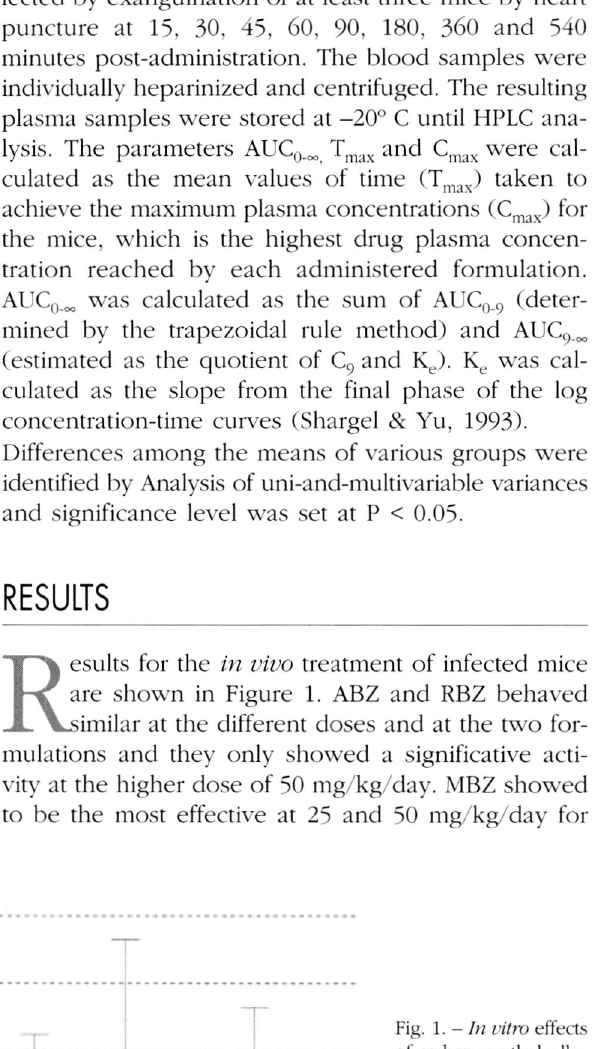
Fig. 1. -In vitro effects of carboxymethylcellu- lose (CMC)- and poly­ vinylpyrrolidone (PVP) preparations of alben­ dazole (ABZ), ricoben­ dazole (RBZ) and me­ bendazole (MBZ) on Echinococcus granu losus cyst viability in experimentally infec­ ted mice. Results are gi­ ven as mean percen­ tage of viable cysts (bars) ± standard de­ viation (lines). The same letter within each column denotes that no significant diffe­ rences (p < 0.05) were